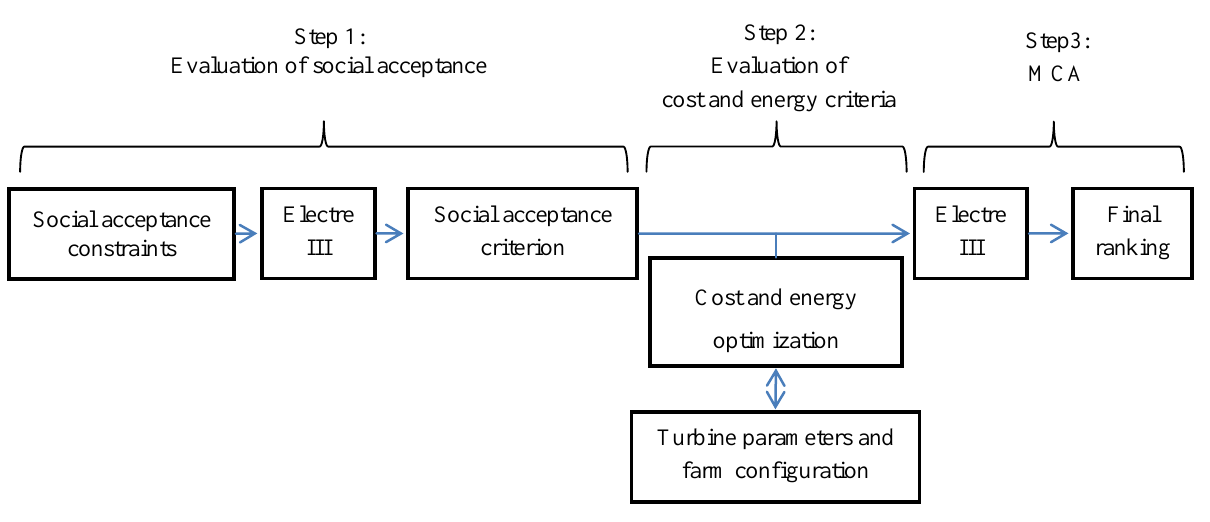
Figure 2. Methodology